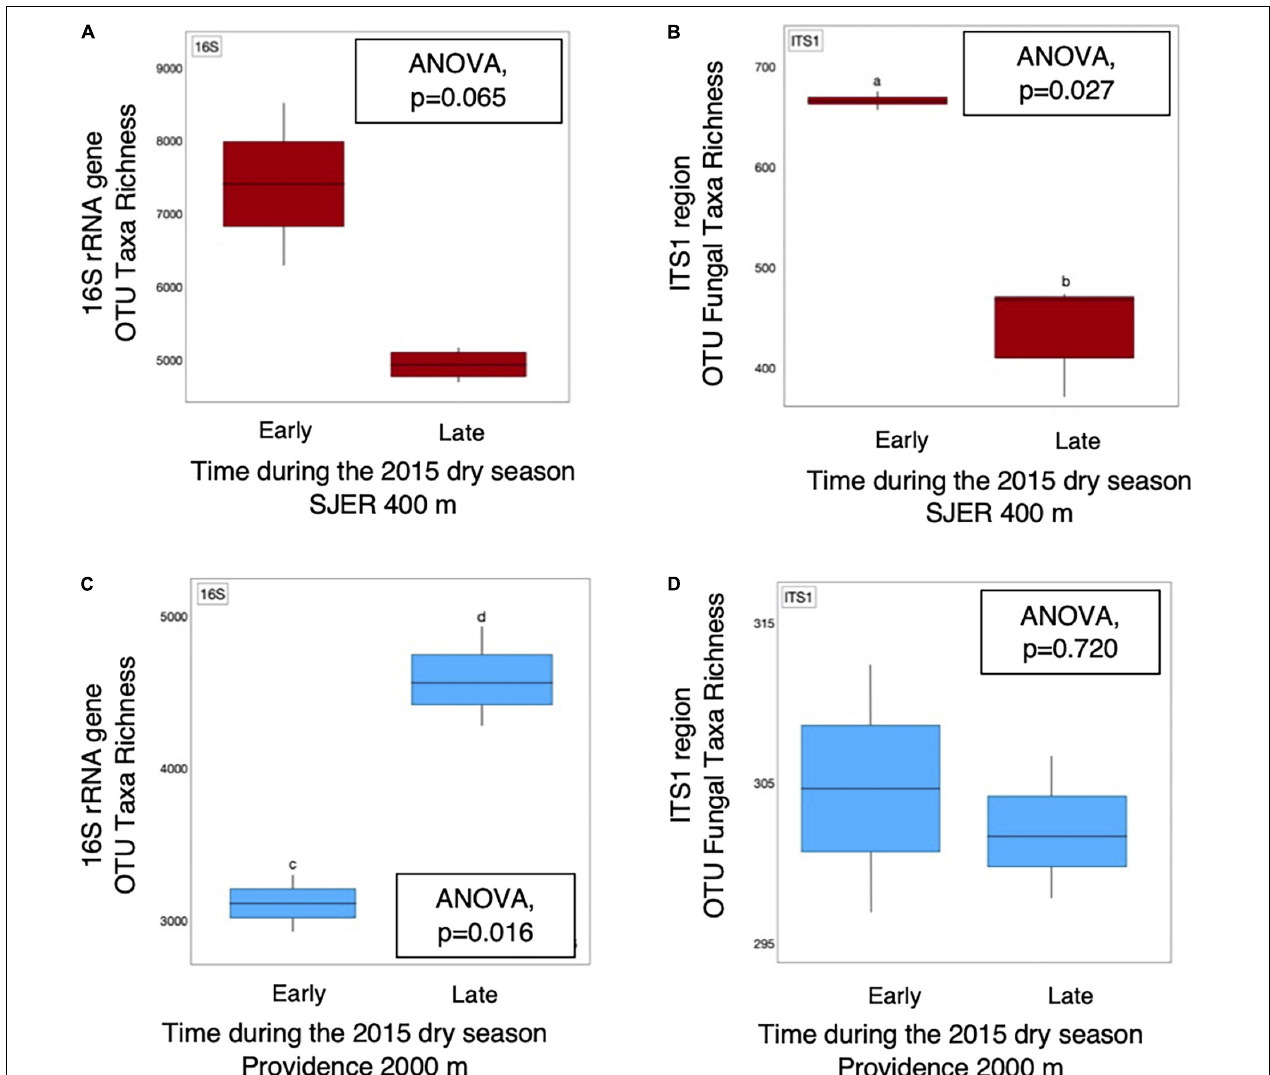
FIGURE 5 | OTU taxa richness of dust microbial communities detected from 16S rRNA marker genes and amplicons from the fungal ITS1 region varied throughout the 2015 dry season. Bacterial (A) taxa richness was equivalent, with marginal differences detected, at SJER (400 m), the lowest elevation site throughout the 2015 dry season. At the same site, fungal (B) taxa richness was significantly higher in July (early in the dry season), than late in the dry season (in October). In contrast, at Providence (2,000 m), the second highest site, dust bacterial (C) taxa richness was significantly lower early in the dry season, than later during that same dry season. Dust fungal richness (D) was equivalent at Providence throughout that same time